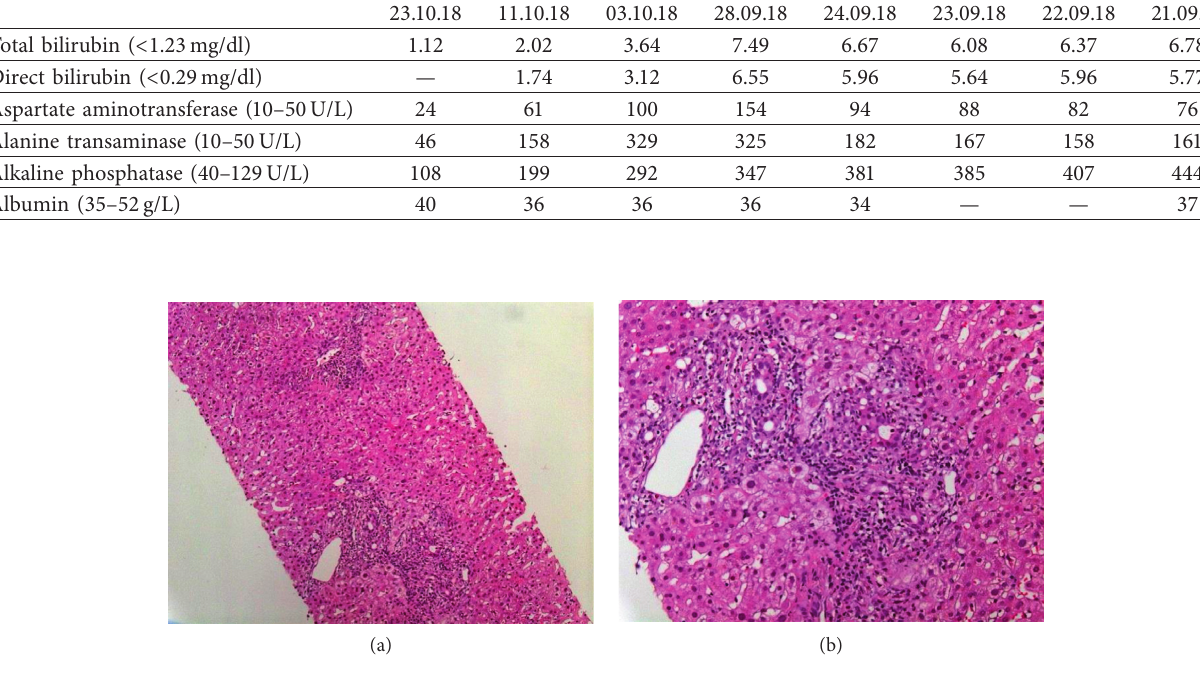
Figure 1: (a) Performed liver biopsy which showed mild-to-moderate portal hepatitis with interface component, minimal lobular component, eosinophilia, bile duct injury, and mild perisinusoidal fibrosis. (b)